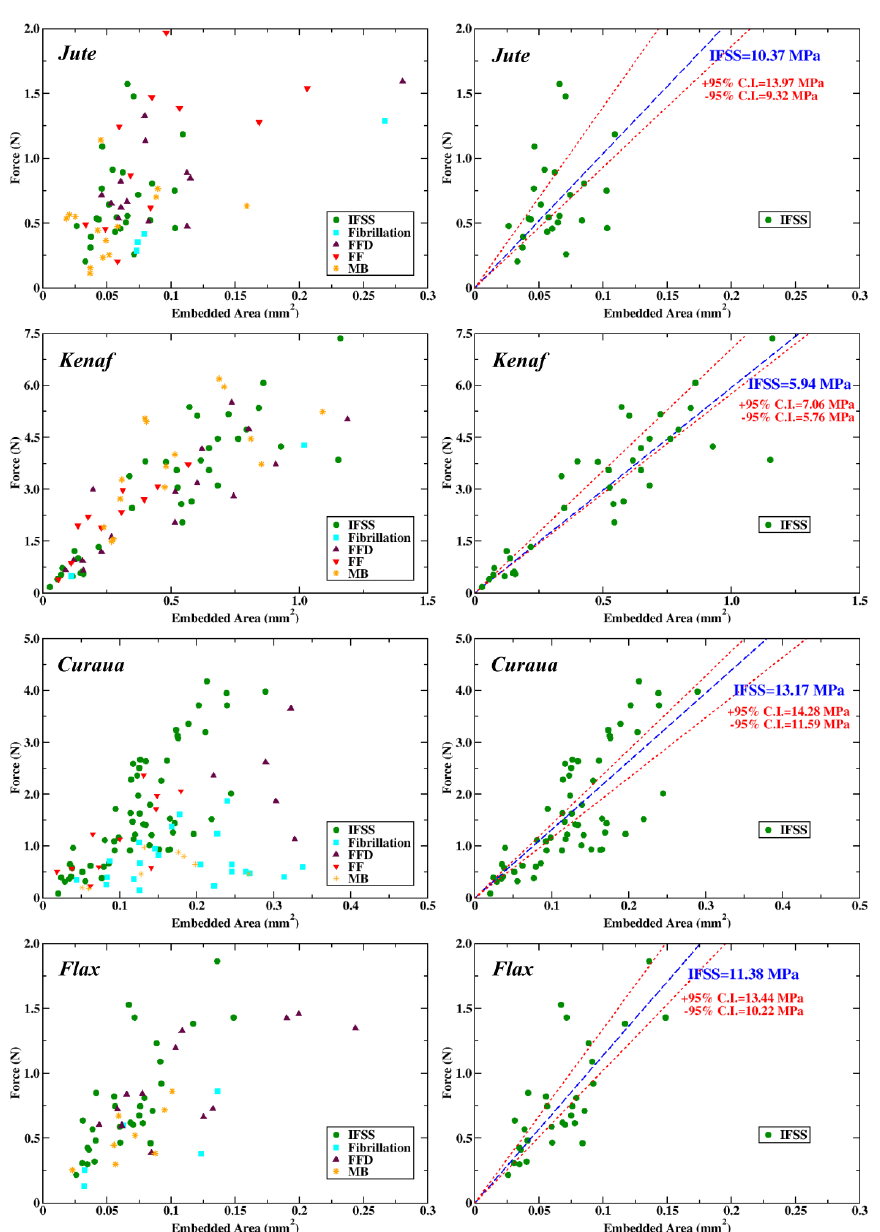
Figure 6. Microbond test results of jute, kenaf, curaua, and flax fibres in terms of debonding force versus embedded area. Left panel shows all data obtained from the test consist of different failure mechanisms. Right panel shows data only from samples that displayed a successful interfacial failure. Linear fit (blue dashed lines) was applied to the data, and results are shown in the figure with the upper and lower 95% confidence intervals (red dotted